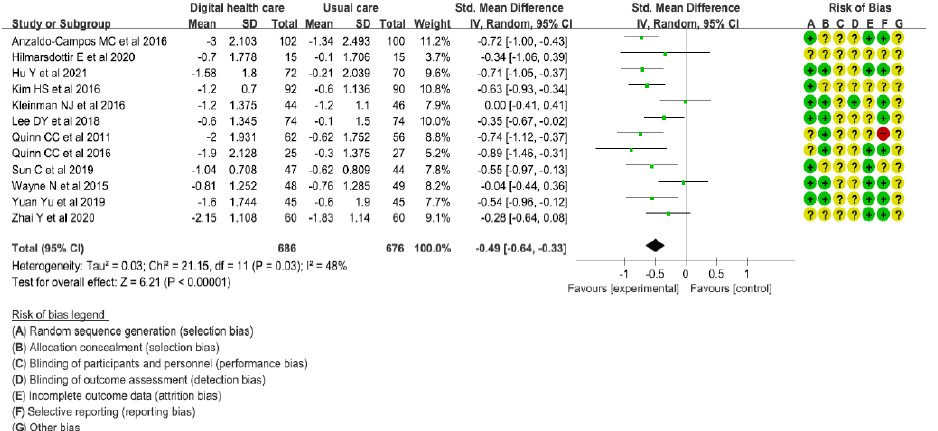
Figure 4. Forest plot for meta-analysis results of